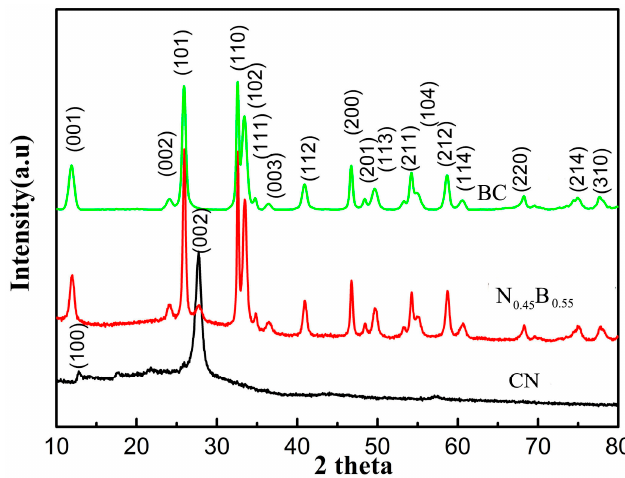
Figure 1. XRD patterns of the as-obtained BiOCl, g-C 3 N 4 , and N 0.45 B 0.55 samples.